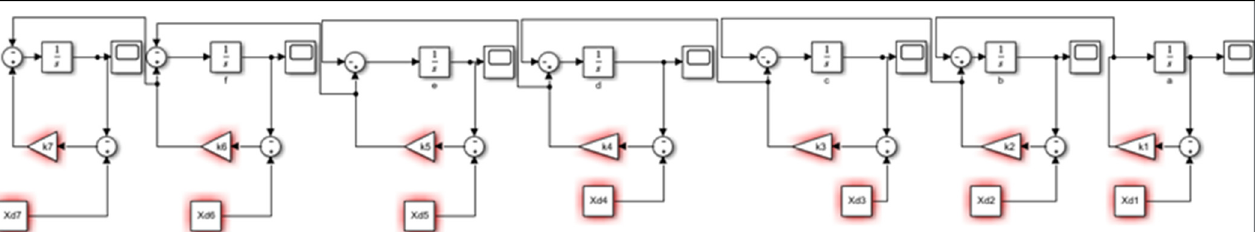
Figure 35. Block diagram of the packaging process, n = 7.